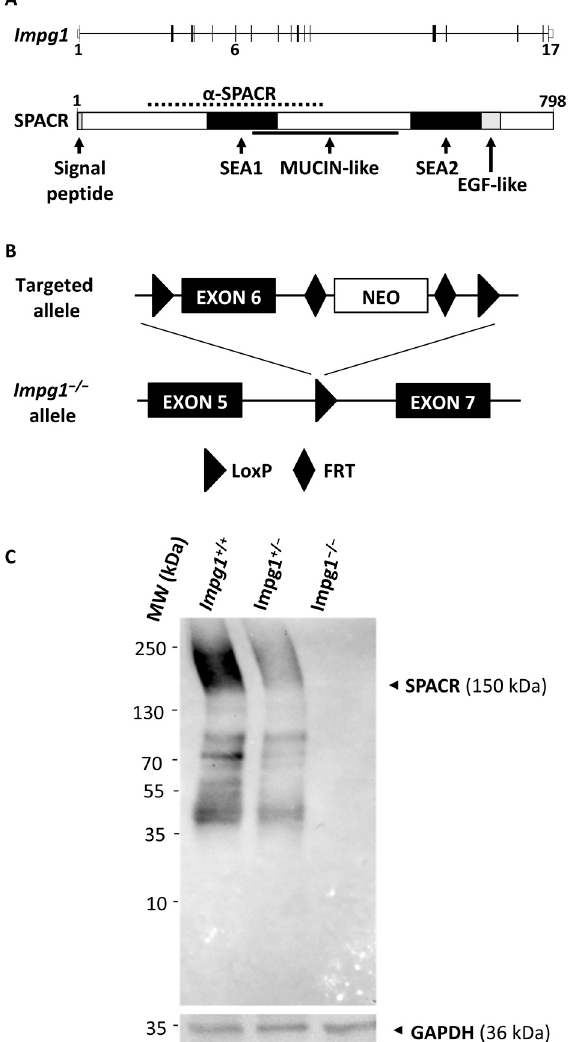
Figure 1. Validation of the Impg1 − / − mouse model. ( A ) Schematic representation of the exon-intron (exons 1 to 17) structure of Impg1 and the domain structure of its encoded SPACR protein (amino acids 1 to 798), including the signal peptide, the N-terminal SEA1 and C-terminal SEA2 domains, the mucin-like domain, and the EGF-like domain. The anti-SPACR mouse monoclonal antibody ( α -SPACR) was raised against amino acids 121–420 (dotted line). ( B ) The exon 6 (black box) of Impg1 mouse was floxed in C57BL/6J embryonic stem cells to disrupt the open reading frame. Arrowheads indicate the loxP sites of the Cre/loxP system. The positive selection marker neo is flanked by FRT sites (diamonds). ( C ) The expression of SPACR protein in wild-type ( Impg1 +/+ ), heterozygote ( Impg1 +/ − ) and SPACR-deficient ( Impg1 − / − ) whole retina lysates was analyzed by Western blotting using a mouse monoclonal antibody against SPACR. GAPDH expression was used as protein loading control. MW, molecular weight in kilodalton